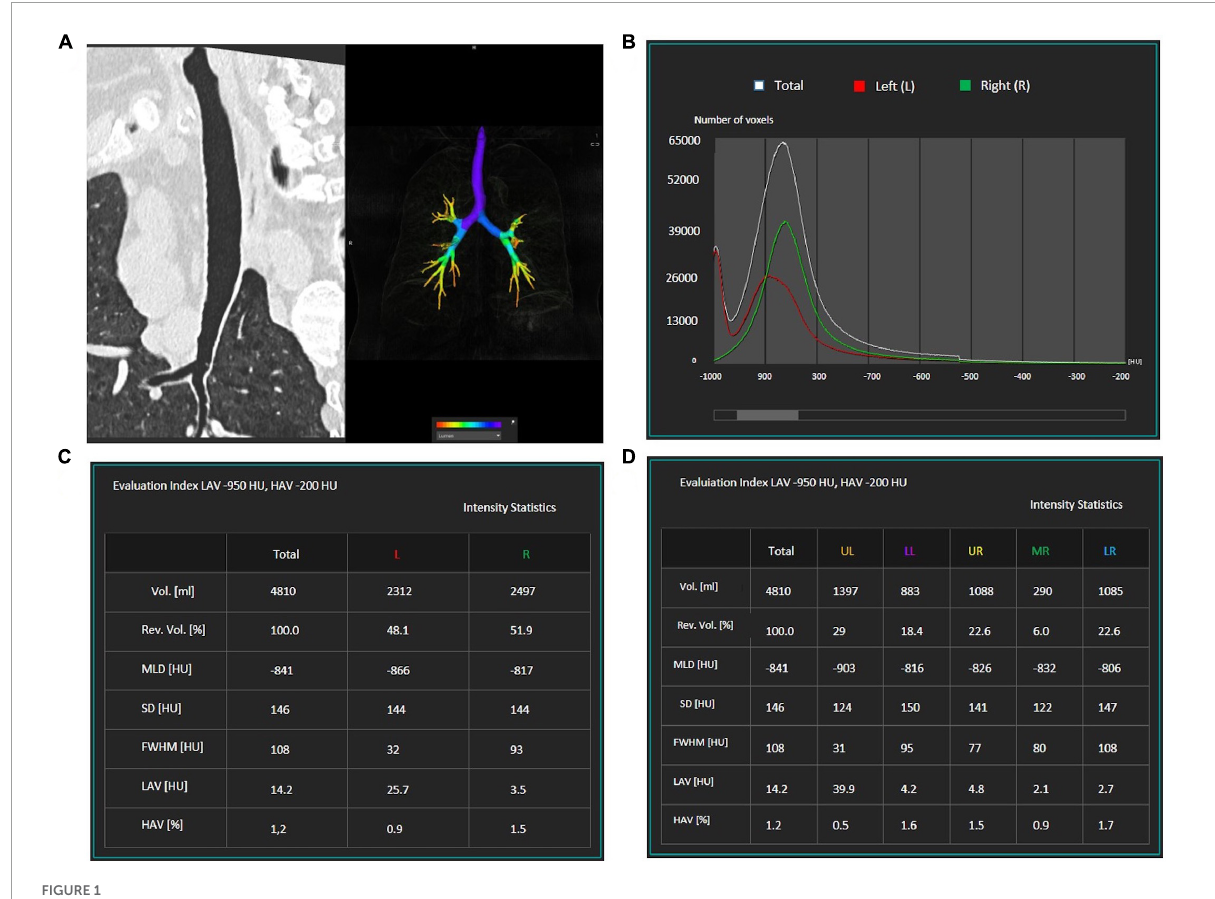
FIGURE1 Example of the semi-automatic software which was used for emphysema quantification. First, the airways (A) lungs, and lobes are segmented. A graphic (B) displays the number of voxels with a specific density: emphysematous areas are characterized by a density lower than –950 HU. The software quantifies lung volumes and recognizes the total volume of emphysematous areas [lower attenuation areas (LAV)] for each lung (C) . The software can be used to calculate the volume of emphysematous areas within each lung lobe (D)